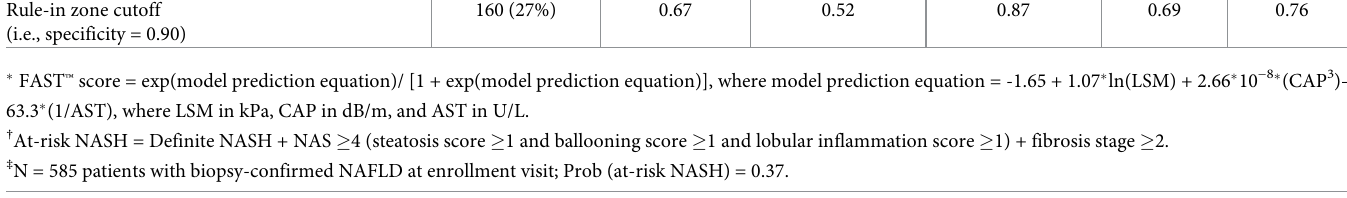
There were 20 patients with unreliable LSMs. Although the mean BMI in the 20 patients with unreliable LSMs was significantly higher (mean 37.4 kg/m 2 ) than the 565 patients with reliable LSMs (mean 34.4 kg/m 2 ), the p-value for the comparison of ROC curves by the 4 BMI categories was similar when these 20 patients were excluded (p-value of 0.043 with all patients vs p-value of 0.035 when excluding patients with unreliable LSMs). Comparison of diagnostic accuracy of FAST ™ vs. other non-invasive diagnostic models for at-risk NASH. A comparison of the diagnostic accuracy of various non-invasive diagnos- tic models for at-risk NASH vs. the FAST ™ score is shown in Table 5. Analysis of the individual components of the FAST ™ score showed that the diagnostic accuracy of each individual com- ponent was significantly lower to that of the FAST ™ score. The addition of ALT to FAST ™ did not result in increase in diagnostic accuracy. AUROC for NFS, FIB-4 index, and APRI were also significantly lower than that of the FAST ™ score, with values of 0.67, 0.73, and 0.74, respectively.